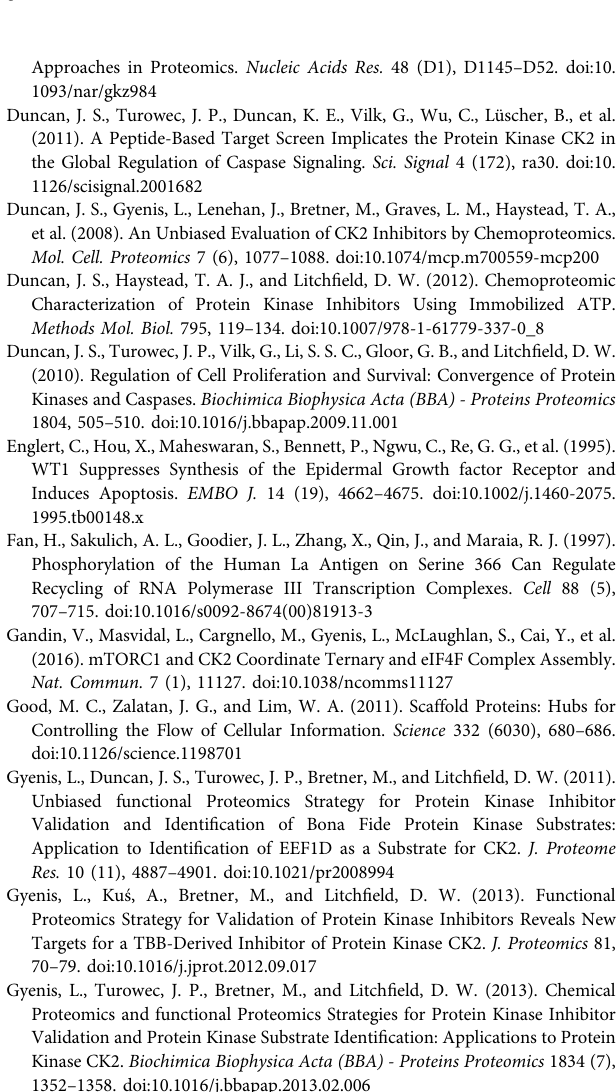
Supplementary Figure S7 | Pro fi le plots of multiplicity 1 phosphopeptides which were signi fi cantly inhibited and partially rescued. Phosphosites with a * represent multiplicity 1 phosphopeptides which satis fi ed our stringent biological criterion for rescue. The horizontal dashed line represents 1.5-fold signi fi cant inhibition (-0.585). Supplementary Figure S8 | CSNK2A1 interaction network. Partially rescued CSNK2 protein substrates and related proteins are depicted in a GeneMANIA network. Previous database information regarding physical interactions (red), co- expression (purple), predicted interactions(orange), geneticinteractions(green), co- localization (blue), and shared protein domains (yellow) were employed in network creation in an ‘ equal by data type ’ weighting approach. Our own list of partially rescuedsubstrateswasutilizedinnetworkcreationandeachassignedavalueof1.If a phosphopeptide was not unique and could have originated from several proteins, all potential proteins were assigned a value of 1. Hashed gene names indicate proteins included in our query list, while those with a solid background are related proteins inserted during GeneMANIA network creation. Proteins implicated in Gene Ontology biological processes are labelled. Supplementary Figure S9 | Gene Ontology terms enriched amongst proteins displayed in the GeneMANIA network created using partially rescued protein substrates. Coverage represents the proportion of displayed proteins which are annotated with a certain Gene Ontology term when compared to all genes in the genome annotated with that same